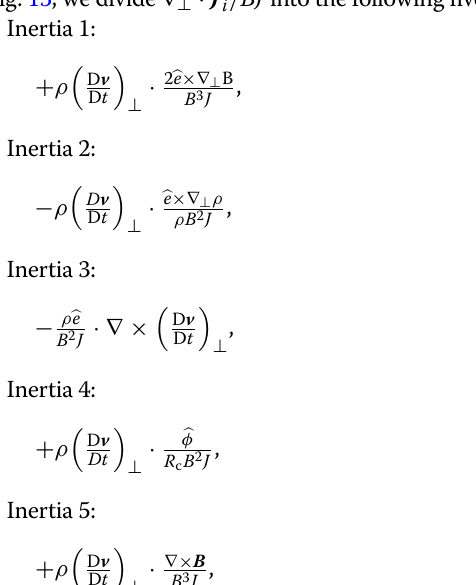
Fig. 14 Type H and L current systems at t according to inertia V A in the same manner as in Fig. 3. The current lines are shown only in the area of β <0.2. The contour line colors change in increments of ± 0.1 . The type L current from A H is not shown in this